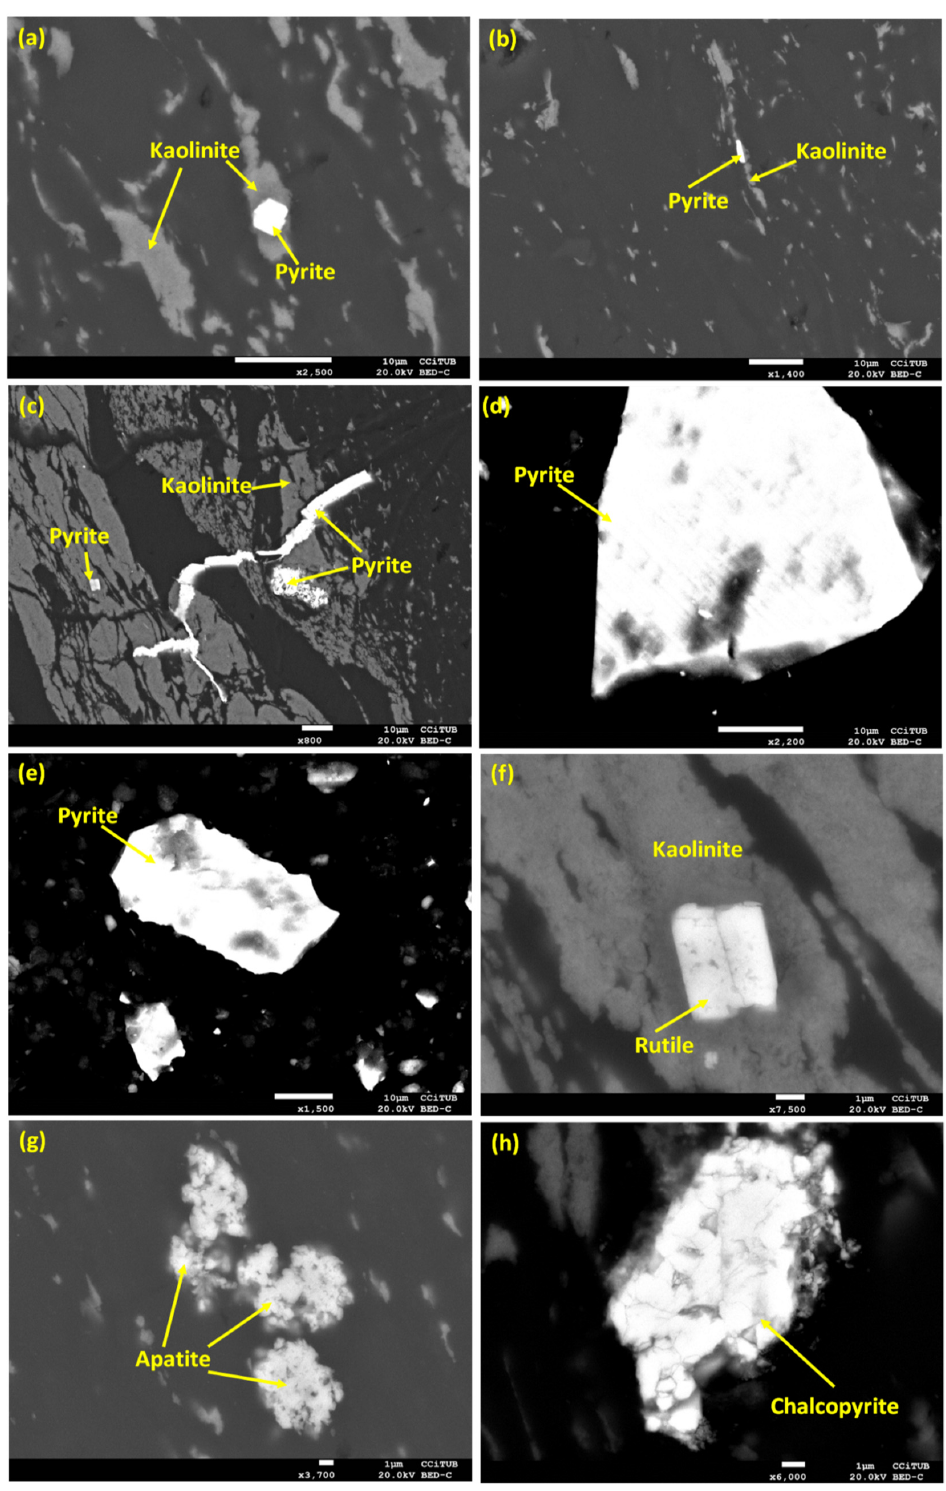
Figure 4. SEM back-scattered electron images of minerals in the Dongdongcoals (sample DD-3). ( a ) Lens-like or banded kaolinite infusinitecell fillings. ( b ) Dispersed and lens-like kaolinite in fusinite cell fillings. ( c ) Massive kaolinite and fracture-filling pyrite. ( d , e ) Massive pyrite, possibly as cleat infilling. ( f ) Syngenetic kaolinite and rutile as infillings of fusinite cells. ( g ) Microcrystal of apatite as infilling of fusinite cells. ( h ) Aggregates of chalcopyrite as infilling of fusinite pores.